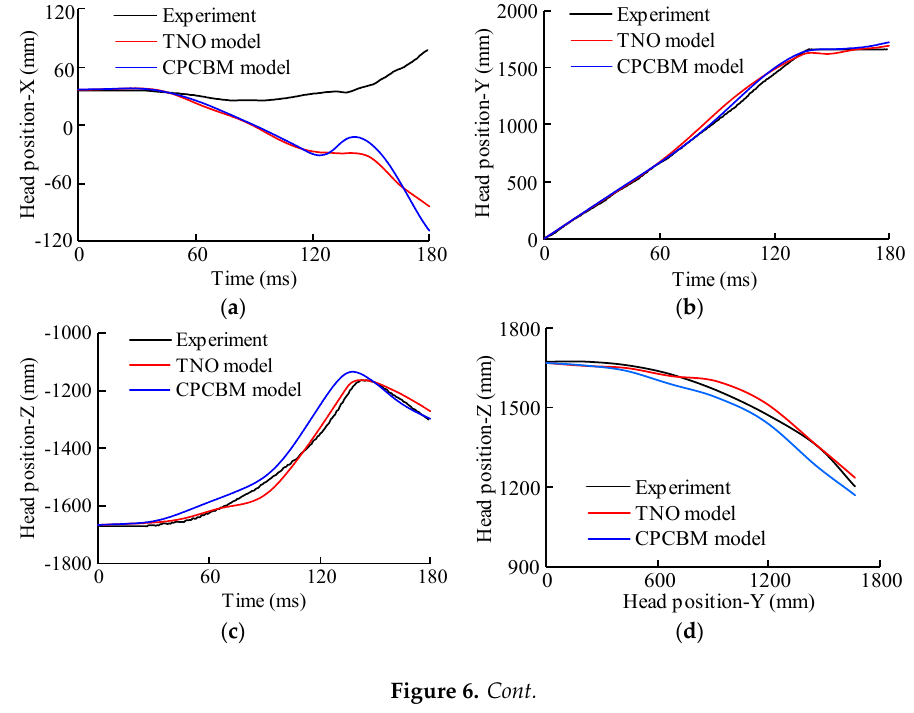
Figure 5. Overall kinematics comparison for test V2370 [17] between the TNO model, CPCBM, and the experimental data: ( a ) posterior view, ( b ) superior view.